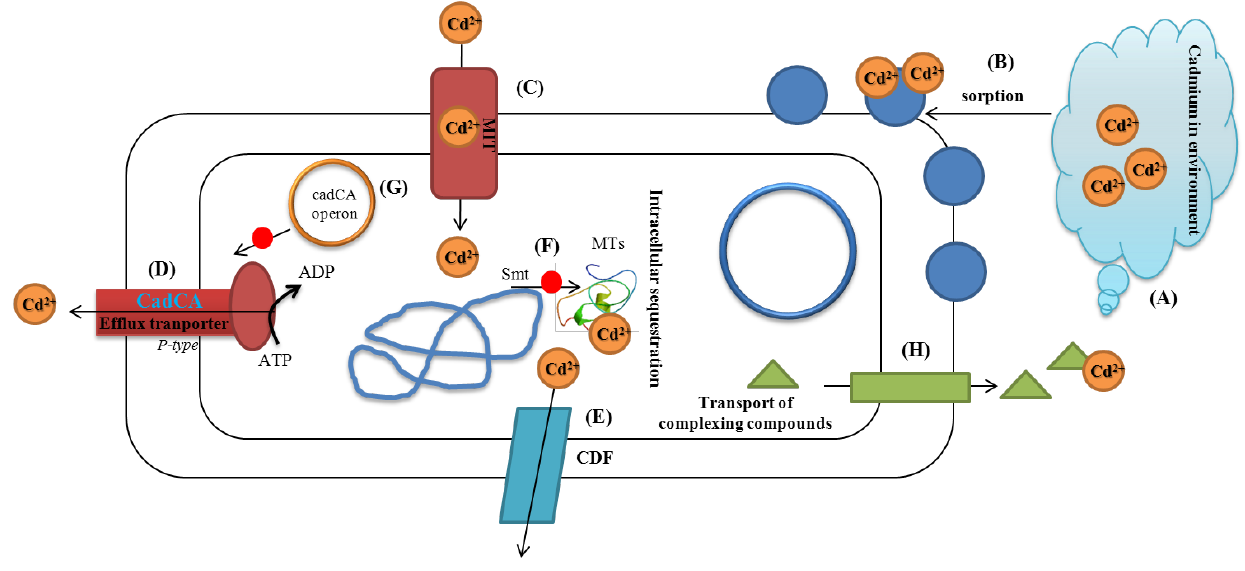
Figure 1. Overview of bacteria cadmium interaction. ( A ) Cd(II) ions occur in environment (soil, water, biota); ( B ) Sorption of Cd(II) on the surface of bacterial wall (protein, cyrbohydrates); ( C ) ion transporter (metal transporting system—MIT, which enable Cd(II) to enter cell; ( D ) Efflux transporter: CadCA protein, which is a P-type ATPase; ( E ) Slow efflux is catalysed by cation-diffusion facilitator CDF; ( F ) Intracellular sequestration: Smt metallothionein locus on bacterial chromosome transcript and translate metallothionein, which binds Cd(II) and, thus, protects a cells against adverse effects of these ions; ( G ) cadCA cadmium resistance operon in Staphylococcus aureus on plasmid transcript and translate CadCA (D). (G) Export of chelating compounds (organic acids), which interact with Cd(II) ions directly in outer space to form complexes, which can not enter the cell. Scheme was adopted and modified according to the following papers